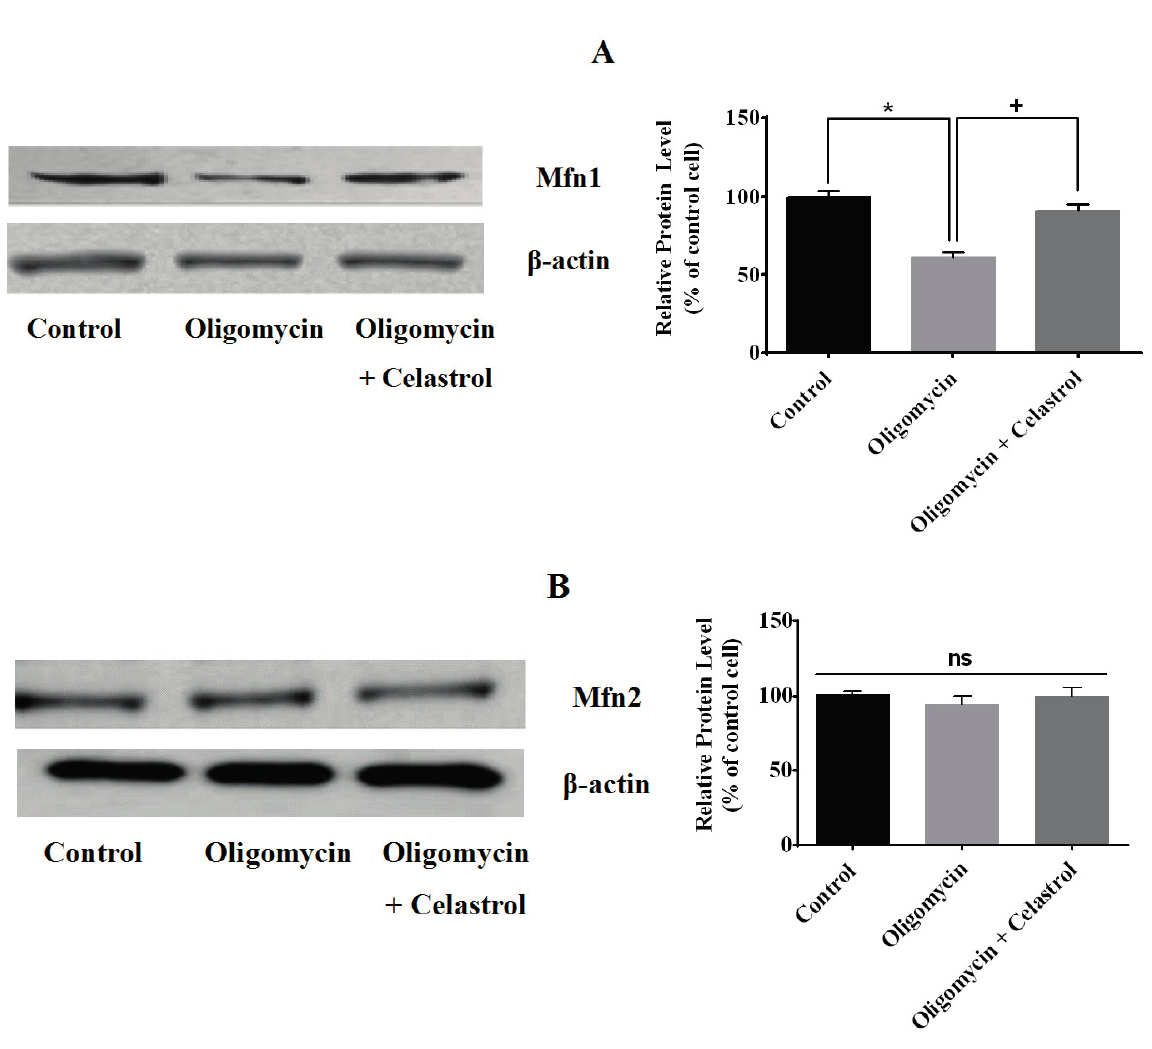
Figure 3. Effects of celastrol on mitochondrial dynamics of differentiated 3T3-L1 adipocytes treated with oligomycin. The mitochondrial fusion/fission protein levels in adipocytes treated with oligomycin, celastrol and control cells were analyzed by Western blot with the corresponding antibodies. Representative Western blot and densitometric analysis of Western blot results for ( A ) Mfn1, ( B ) Mfn2, and ( C ) Drp1 were determined. β -actin was used as loading control. Protein levels measured by densitometry were normalized against β -actin signals. The results are similar of those obtained from three independent experiments. * p < 0.05 vs . untreated control; + p < 0.05 vs . oligomycin-treated cells; ns: not